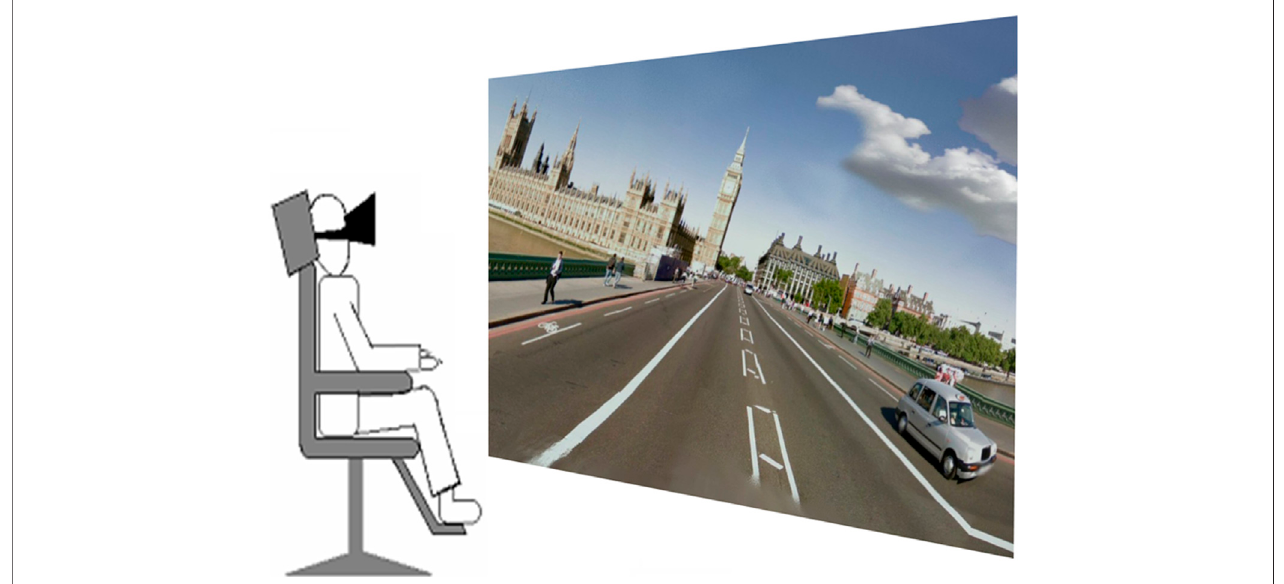
FIGURE 1 | Schematic of the visual stimulus: Rotating scene of complete 360 ° panorama; frequency 0.2 Hz (72 deg/s); “ wobble ” 18 ° axial tilt; fi eld of view with mask to 83.5 ° with circular restriction (Golding et al.,